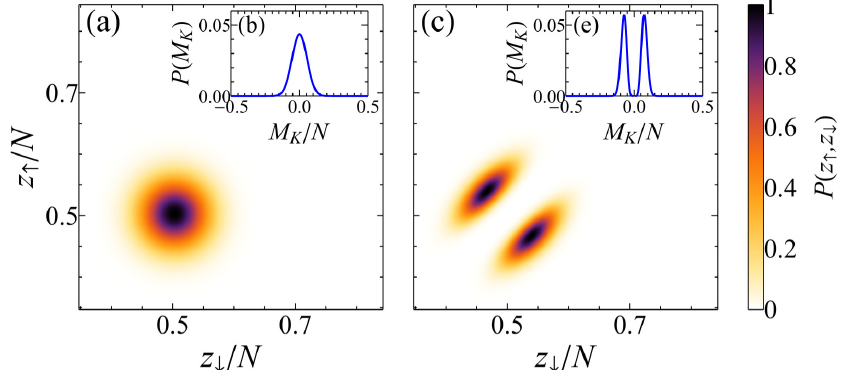
, z ) without measurement ( a ) and with measurement ↑ ↓